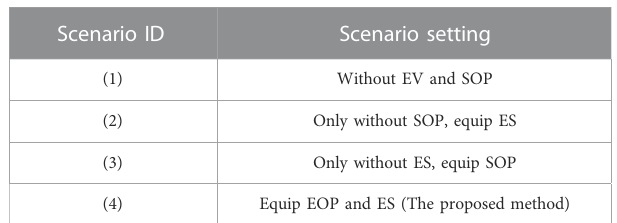
TABLE 2 Scenario setting.